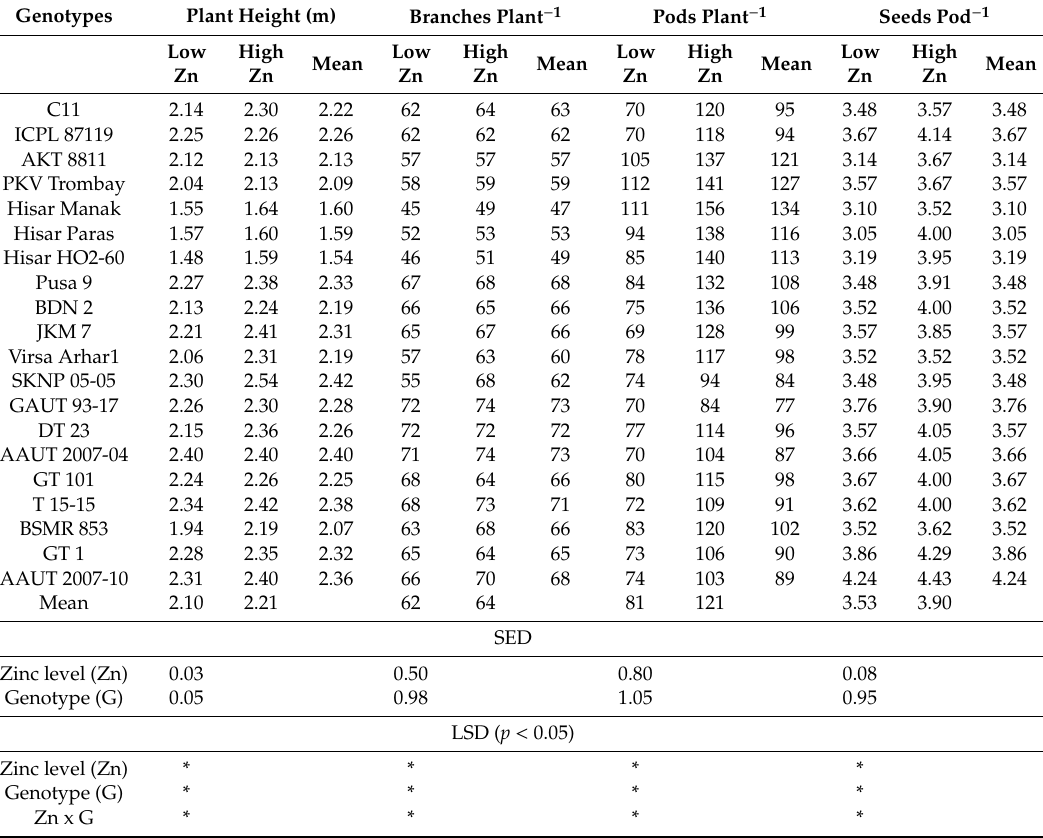
Table 2. Plant height (m), number of branches per plant, number of pods per plant and number of seeds per plant of pigeon pea genotypes under low and high zinc (Zn) treatments. SED = standard error of di ff erence, LSD = least significant di ff erence. * denotes significant at p < 0.05.